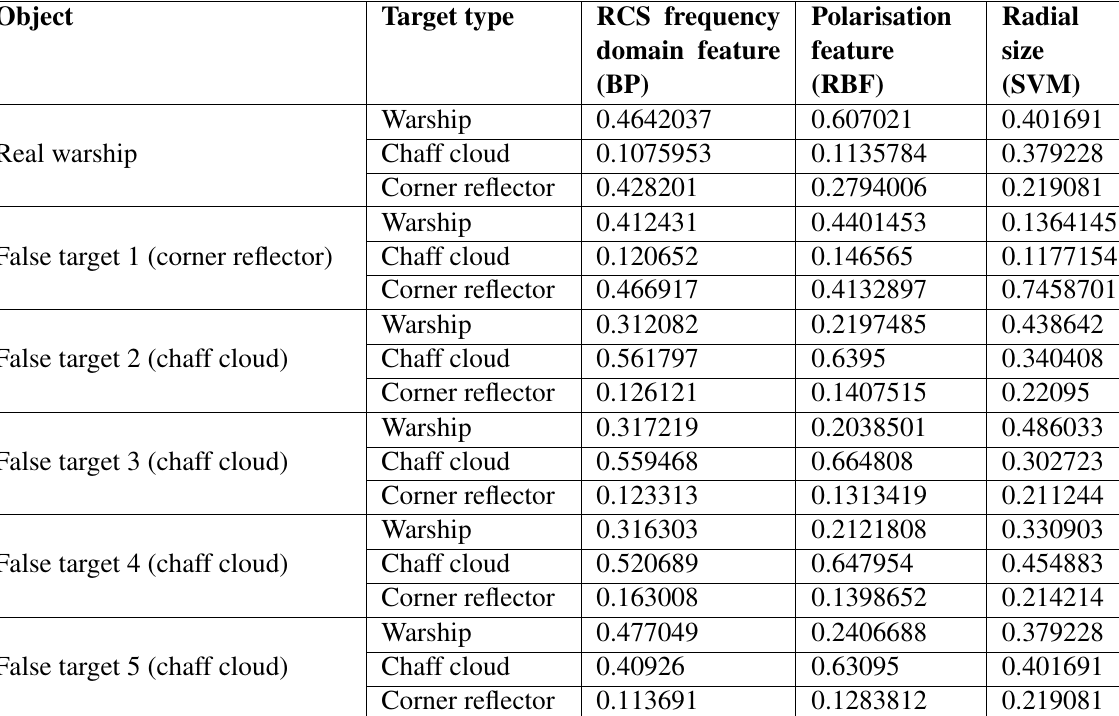
Fig. 3 Missile axis symmetric ‘four targets’ Table 1 Decision